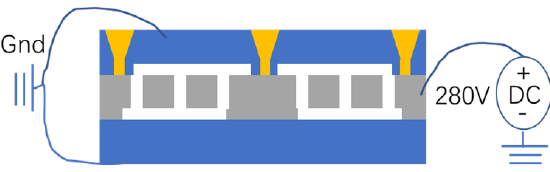
Figure 6. Anodic bonding was used for wafer-level package.